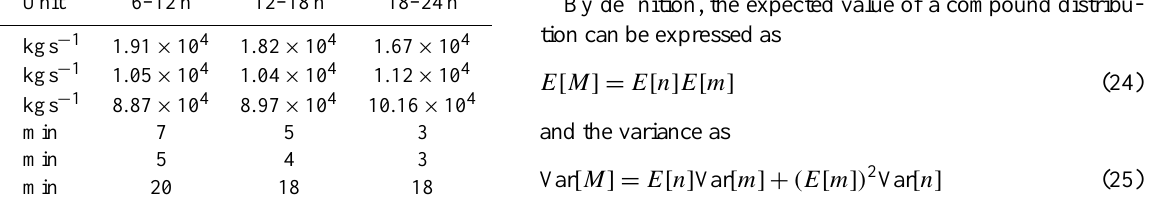
Table 2. Model closure parameters estimated from the cloud track- ing results.